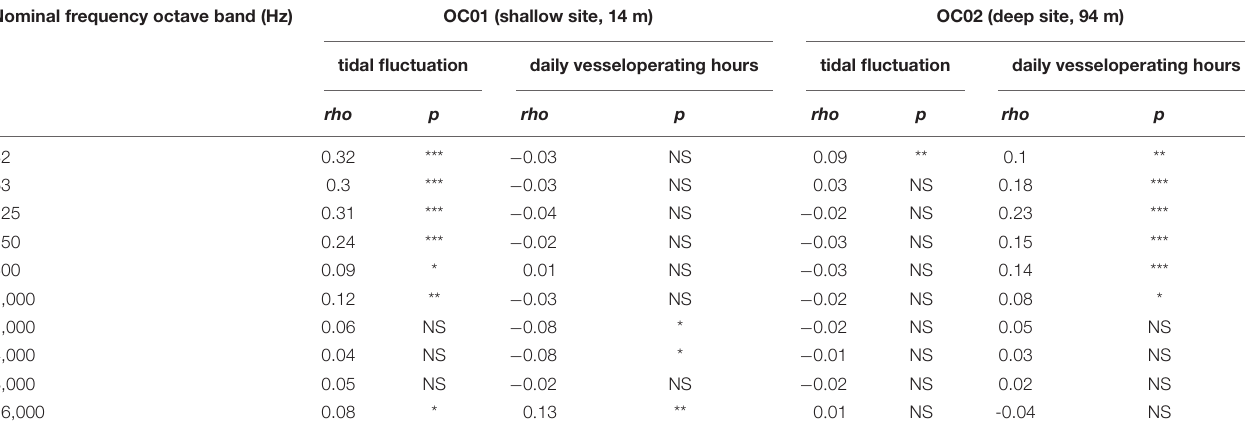
TABLE 3 | Correlation of hourly octave band sound levels with tidal fluctuation or daily vessel operating hours (all vessels documented with AIS) at sites OC01 and OC02. Nominal frequency octave band